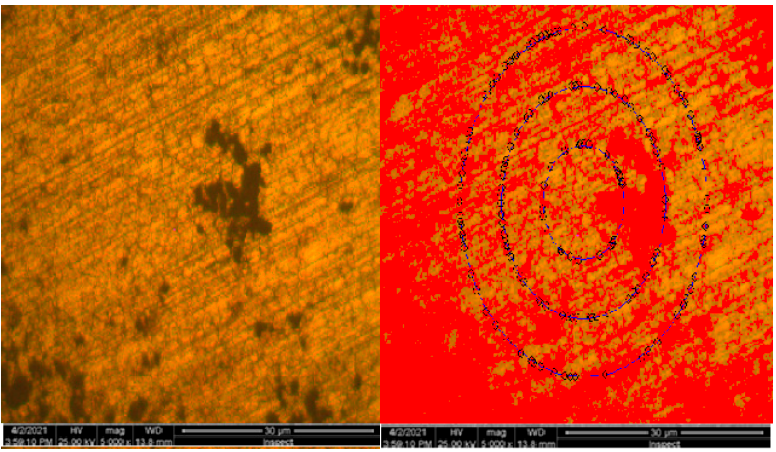
Figure 3. Microscopic appearance of austenitic grains for the forged semi-finished product 10CrMo9-10 [1]. Results obtained for structural investigations by optical microscopy are presented in Figure 4.